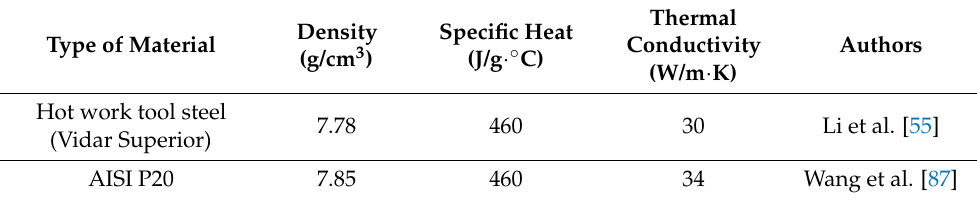
Table 4. Physical and mechanical properties of mold insert materials for